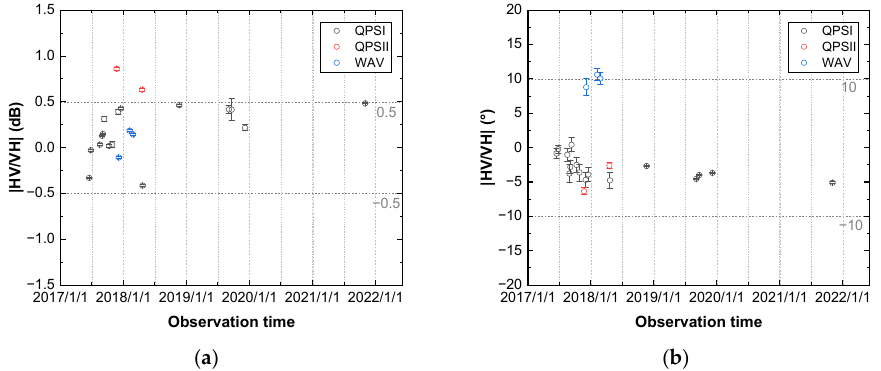
Figure 11. GaoFen-3’s cross-pol channel imbalance assessment using the modified Quegan method in the Amazon rainforest from June 2017 to November 2021. The channel ratios between HV and VH were calculated. ( a ) The cross-pol channel imbalance amplitude; and ( b ) the cross-pol channel imbalance phase.